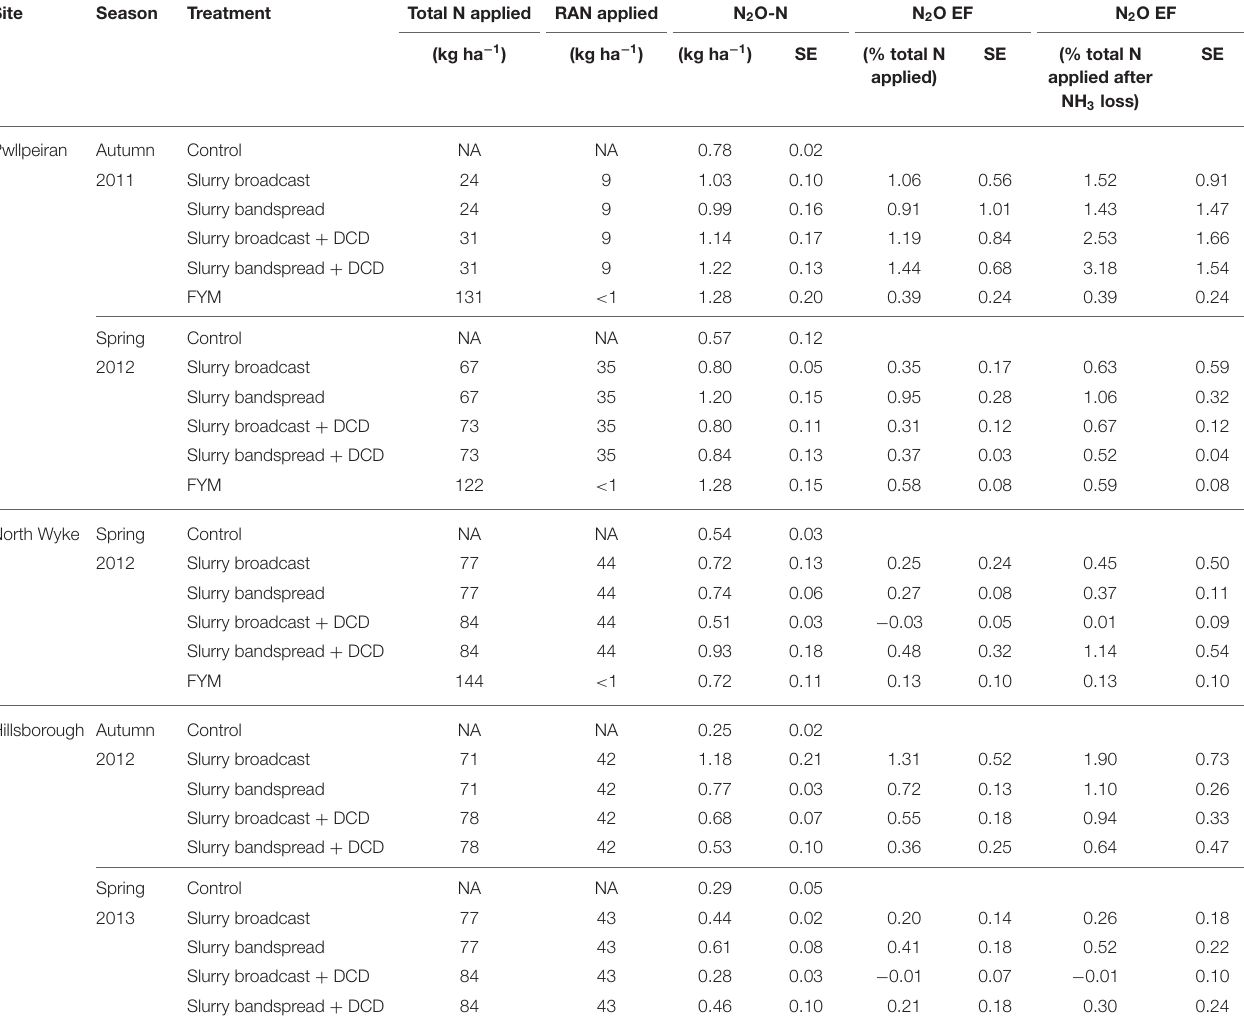
TABLE 9 | Manure nitrogen applied, mean annual N 2 O emissions and emission factors (EFs) at the grassland sites.